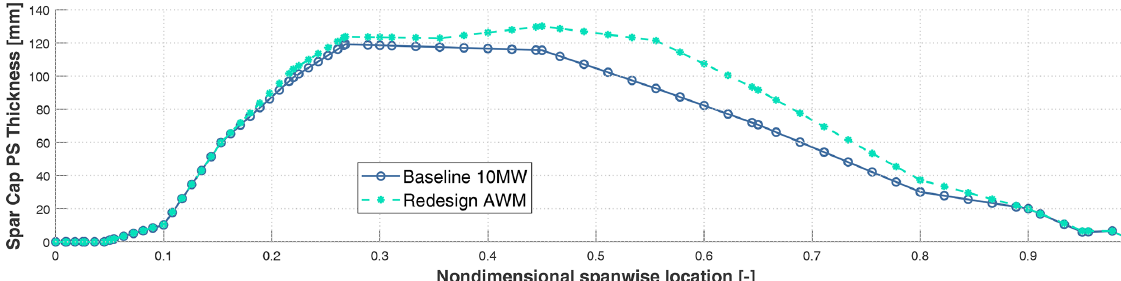
Figure 10. Redesign process including PCM: thickness distribution of the spar caps.